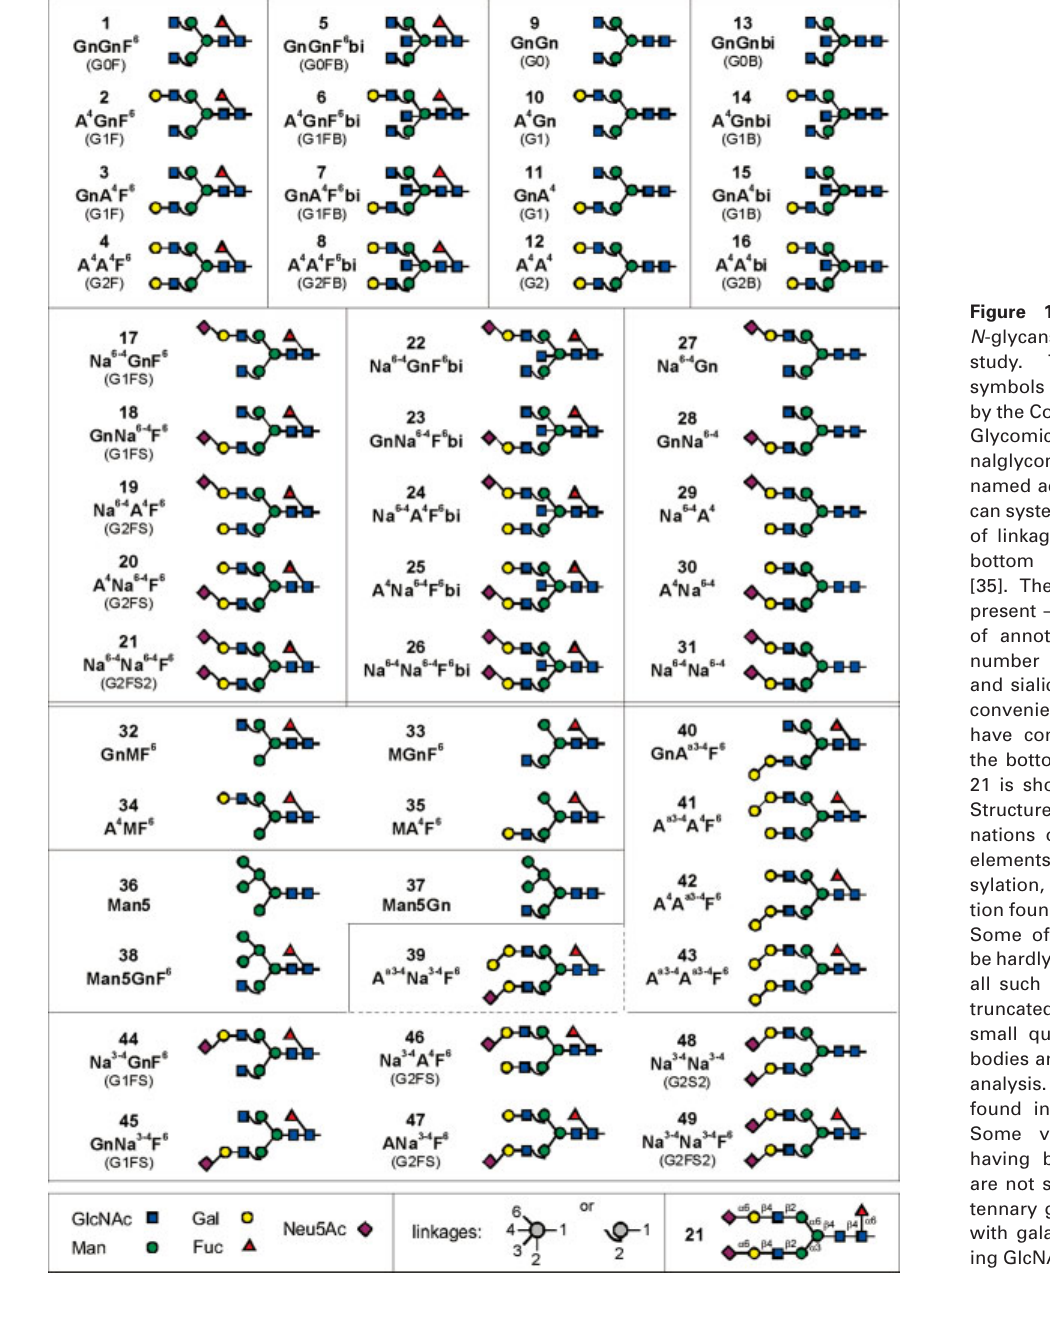
Figure 1. Structures of the N -glycans dealt with in this